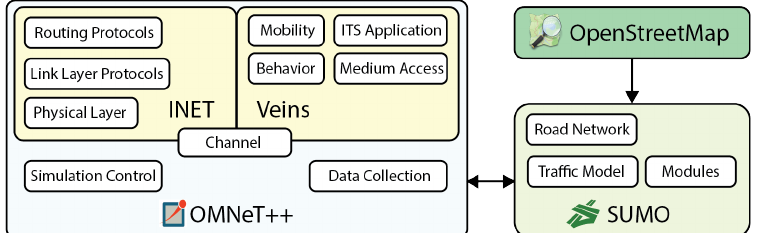
Figure 3. Simulationdesign of the experiments and a subset of the modules utilized from each com-